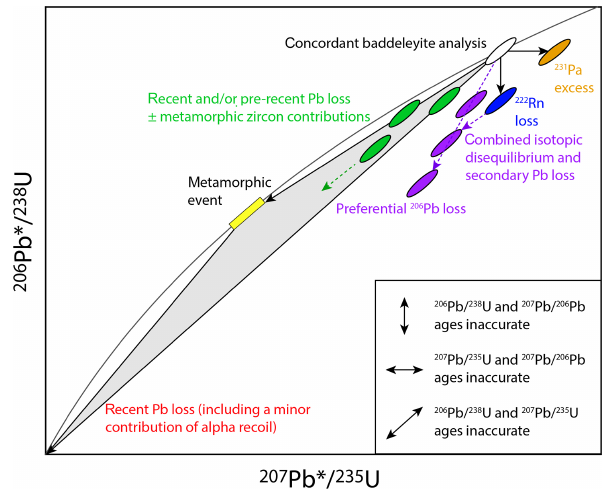
Figure 10. Schematic model of the consequences of different dis- cordance mechanisms on the isotopic composition of